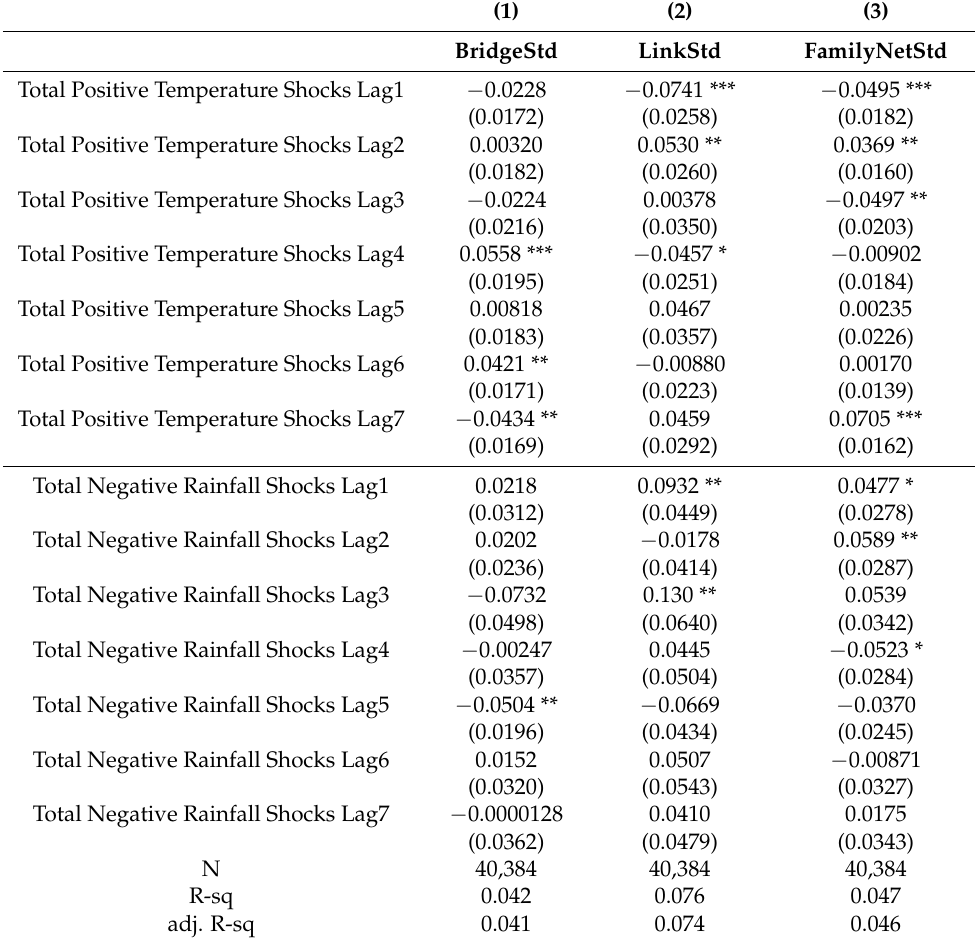
Table A1. Assessing the impact of lagged climate shocks (seven-year) on key measures of social